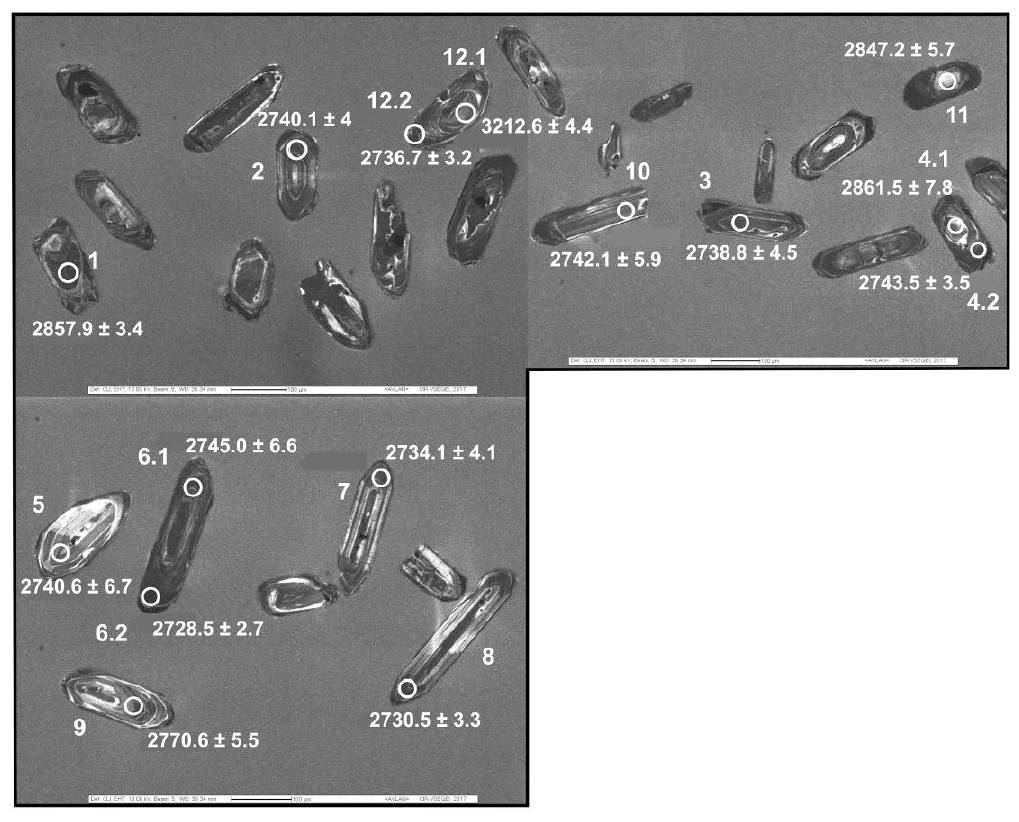
Figure 12. Cathodoluminescent images and age of zircons from rocks of the DW block.